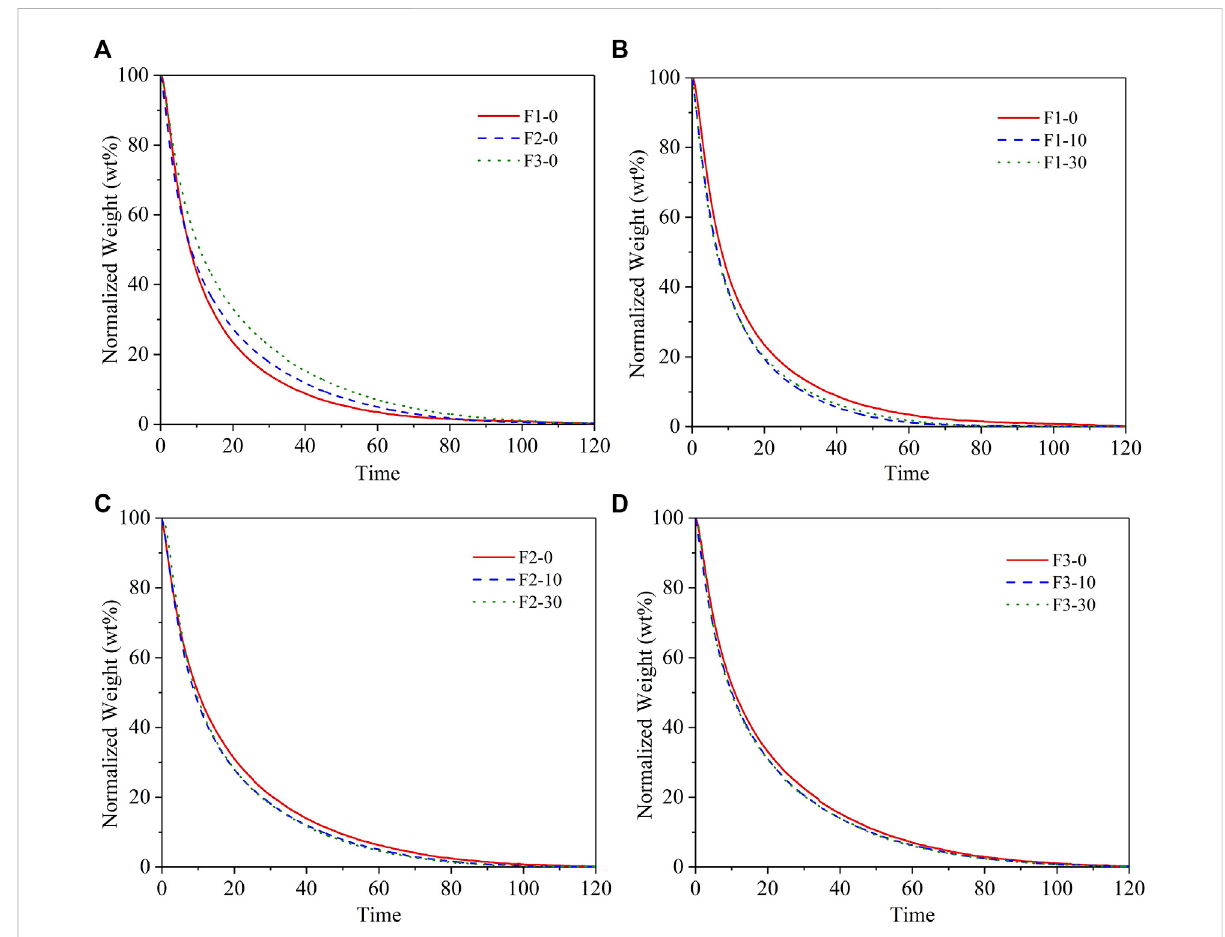
FIGURE 6 TGA results of soot in different magnetic fi elds, (A) without magnetic fi eld, (B) 21% O 2 , (C) 26% O 2 , (D) 31% O 2